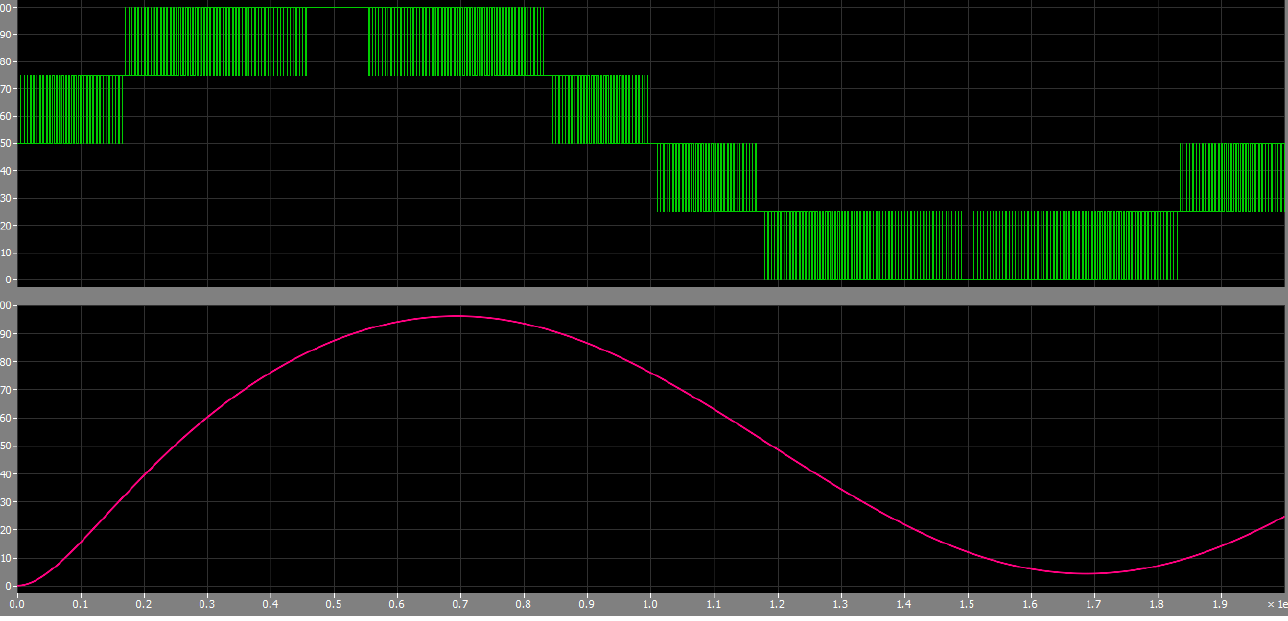
Figure 8. Simulation results given by the PLECS model: output voltage V out (upper subplot) and filtered voltage across C L (lower